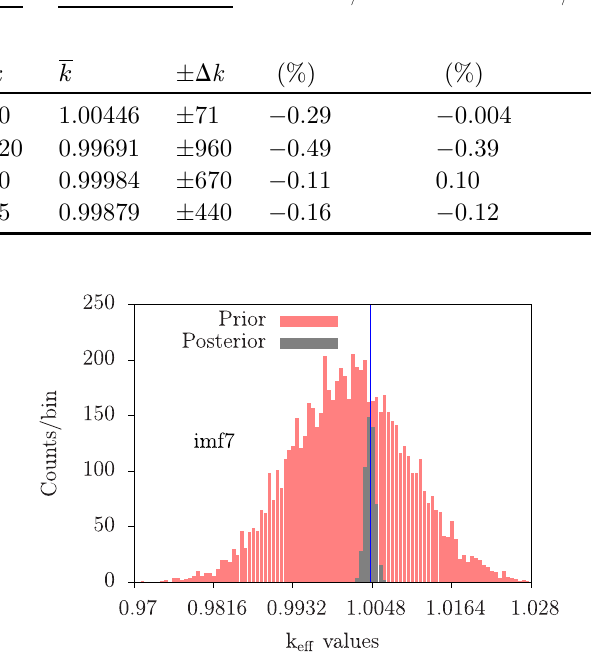
Table 3. Prior and posterior average k C/E values are also indicated. The statistical uncertainty for each MCNP6 calculation is in the order of 25 pcm.